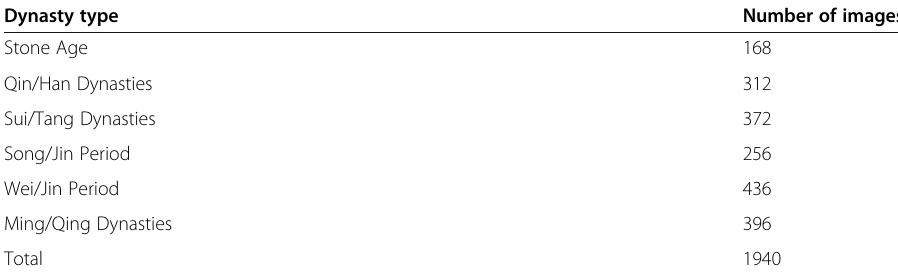
Table 2 Number of murals in each dynasty